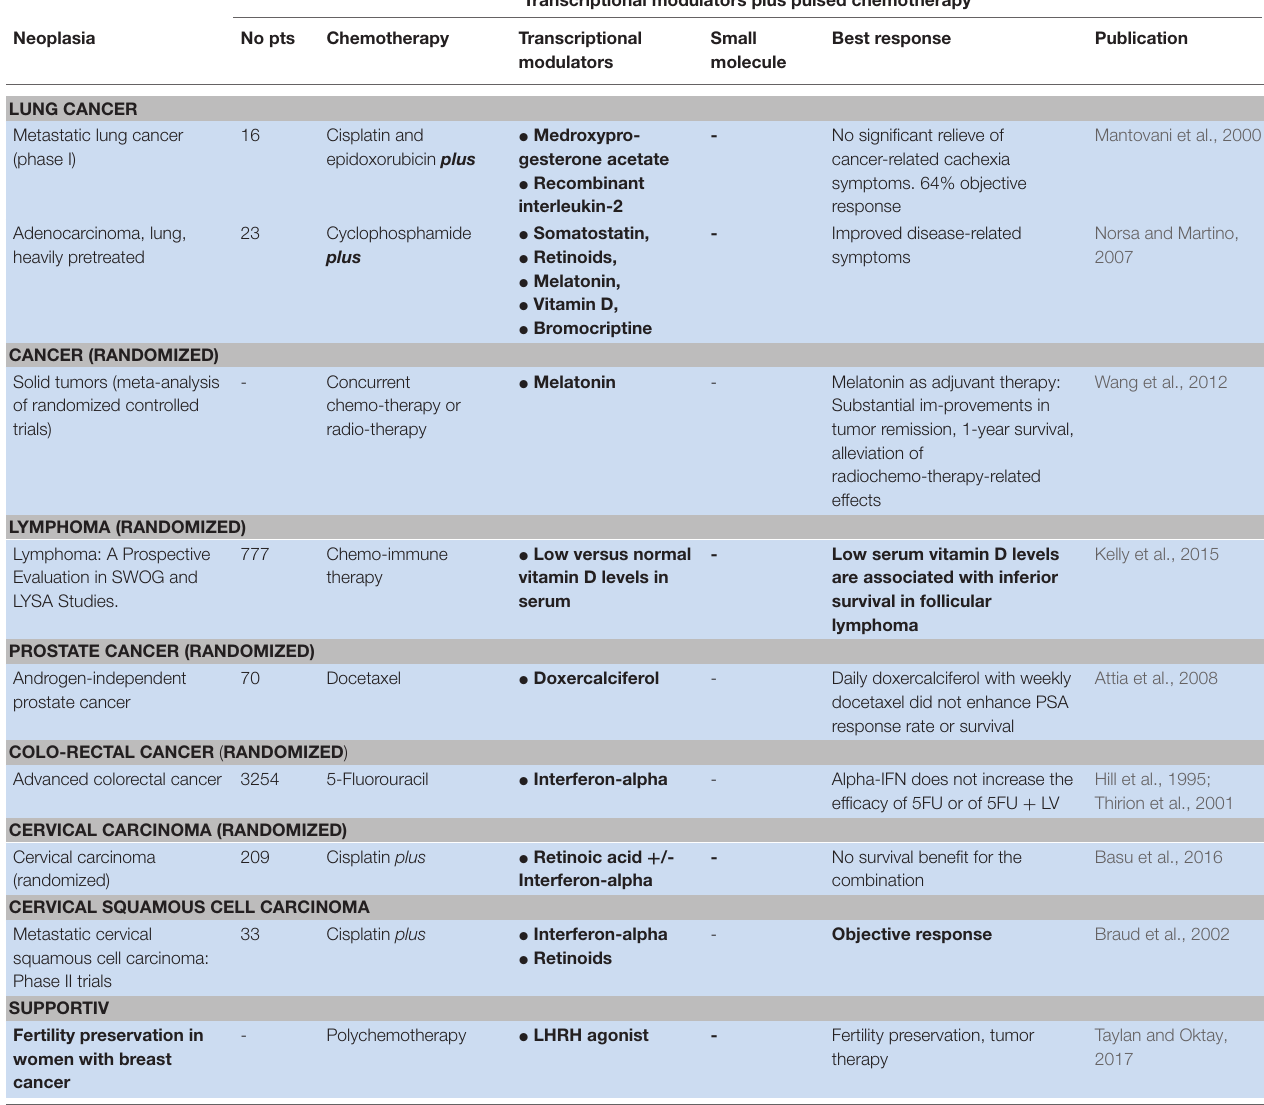
TABLE VII | Communicative reprogramming of tumor